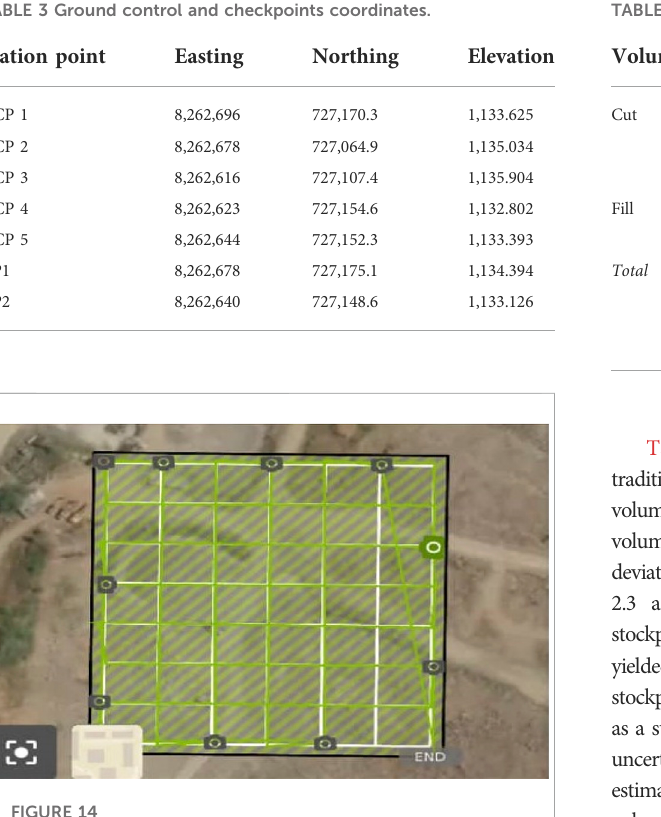
FIGURE 14 Double grid drone path.